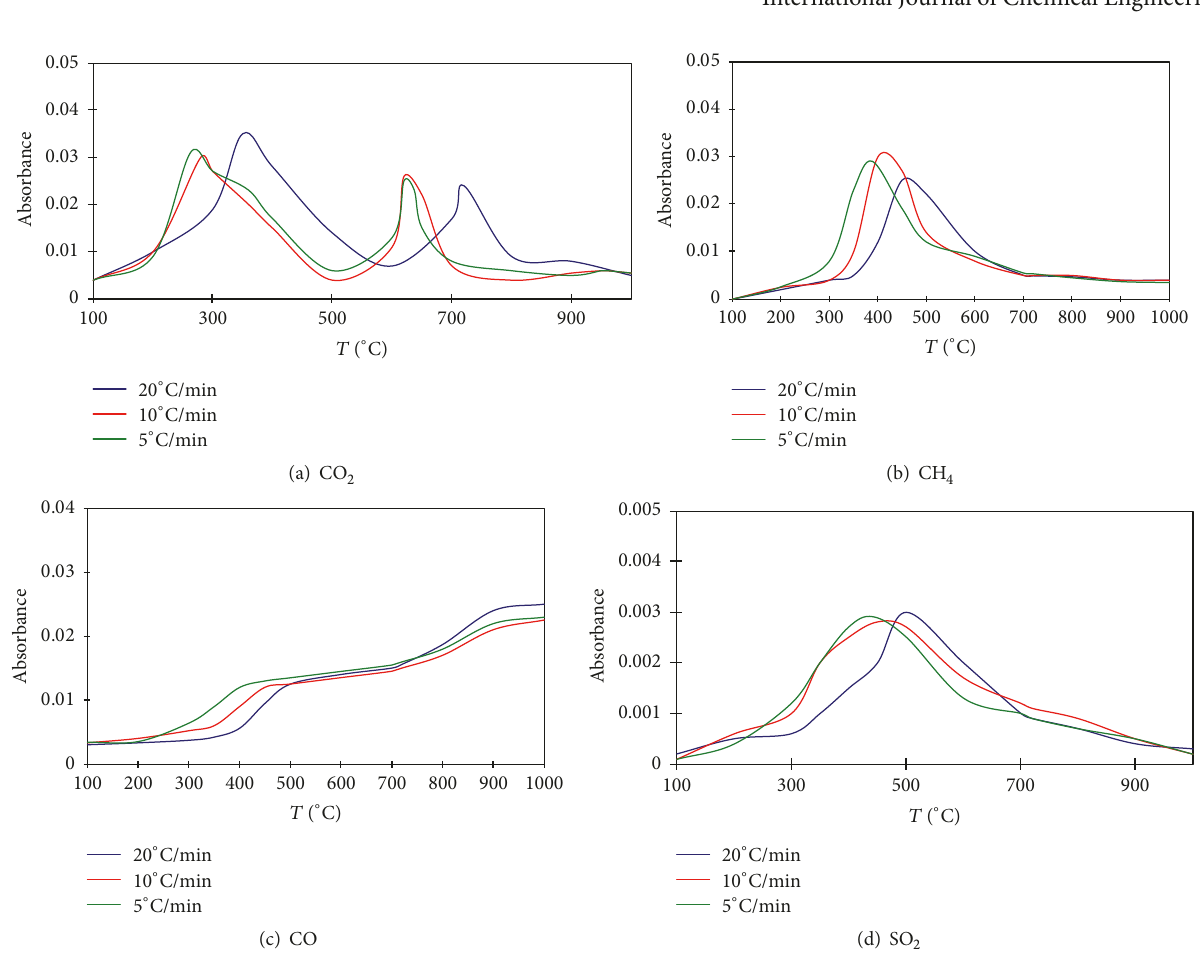
to 500 ∘ C at 20 ∘ C/min, 480 ∘ C at 10 ∘ C/min, and 472 ∘ C at 5 ∘ C/min, respectively. It is known that the SO 2 evolution peak shifted to the low temperature region and the peak value decreased with the decrease of heating